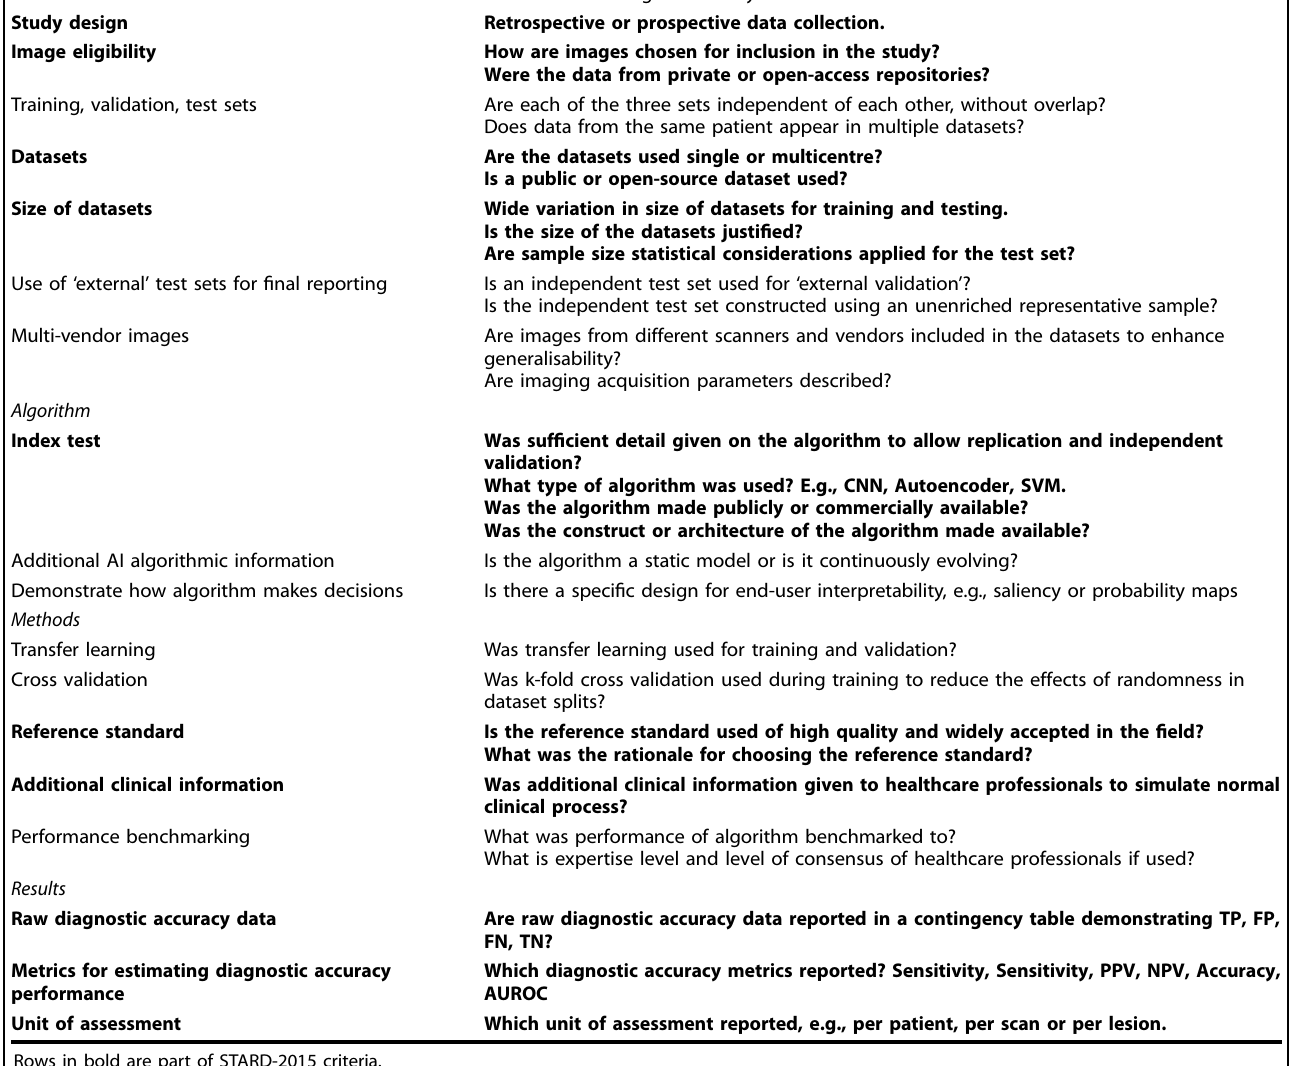
Is there quality control of the images being used to train the algorithm? I.e., were poor quality images excluded. Were relevant images manually selected?